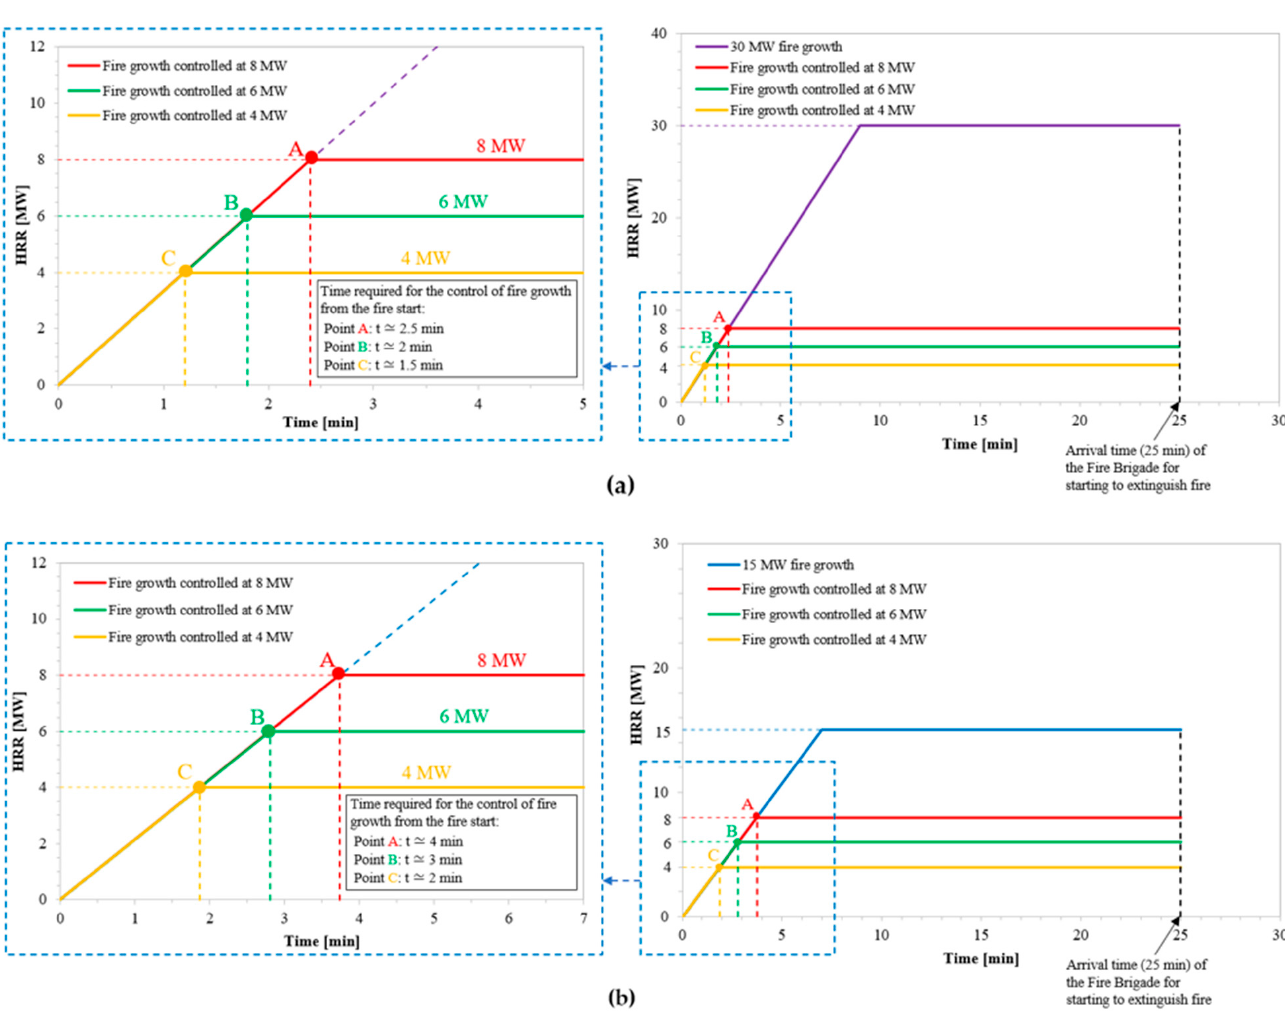
Figure 3. Modified fire curves, with reference to the case of: ( a ) HRR max = 30 MW and ( b ) HRR max = 15 MW, when the micronized water system is activated at 8, 6, and 4 MW of the fire growth phase (i.e., points A, B, and C), respectively.